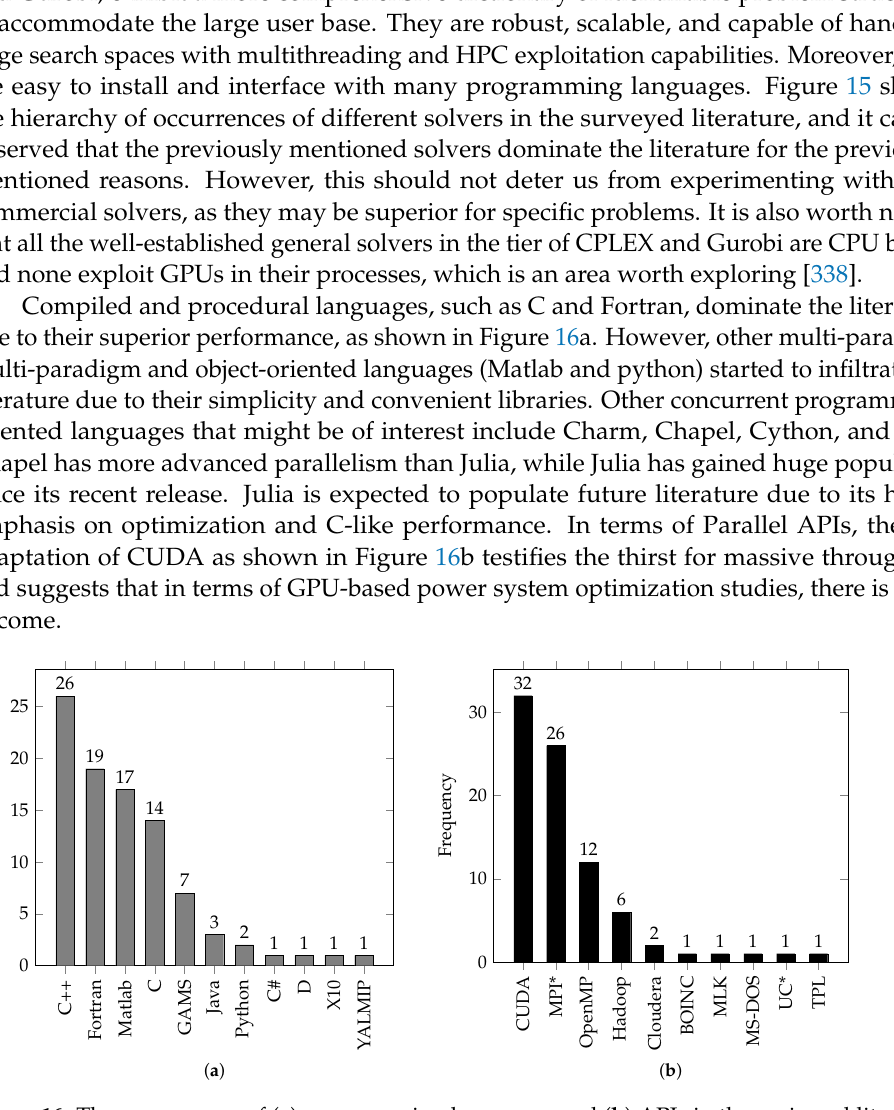
Figure 16. The occurrences of ( a ) programming languages and ( b ) APIs in the reviewed literature. * MPI includes MPICH, mpi4py, MultiMATLAB. UC: Unix